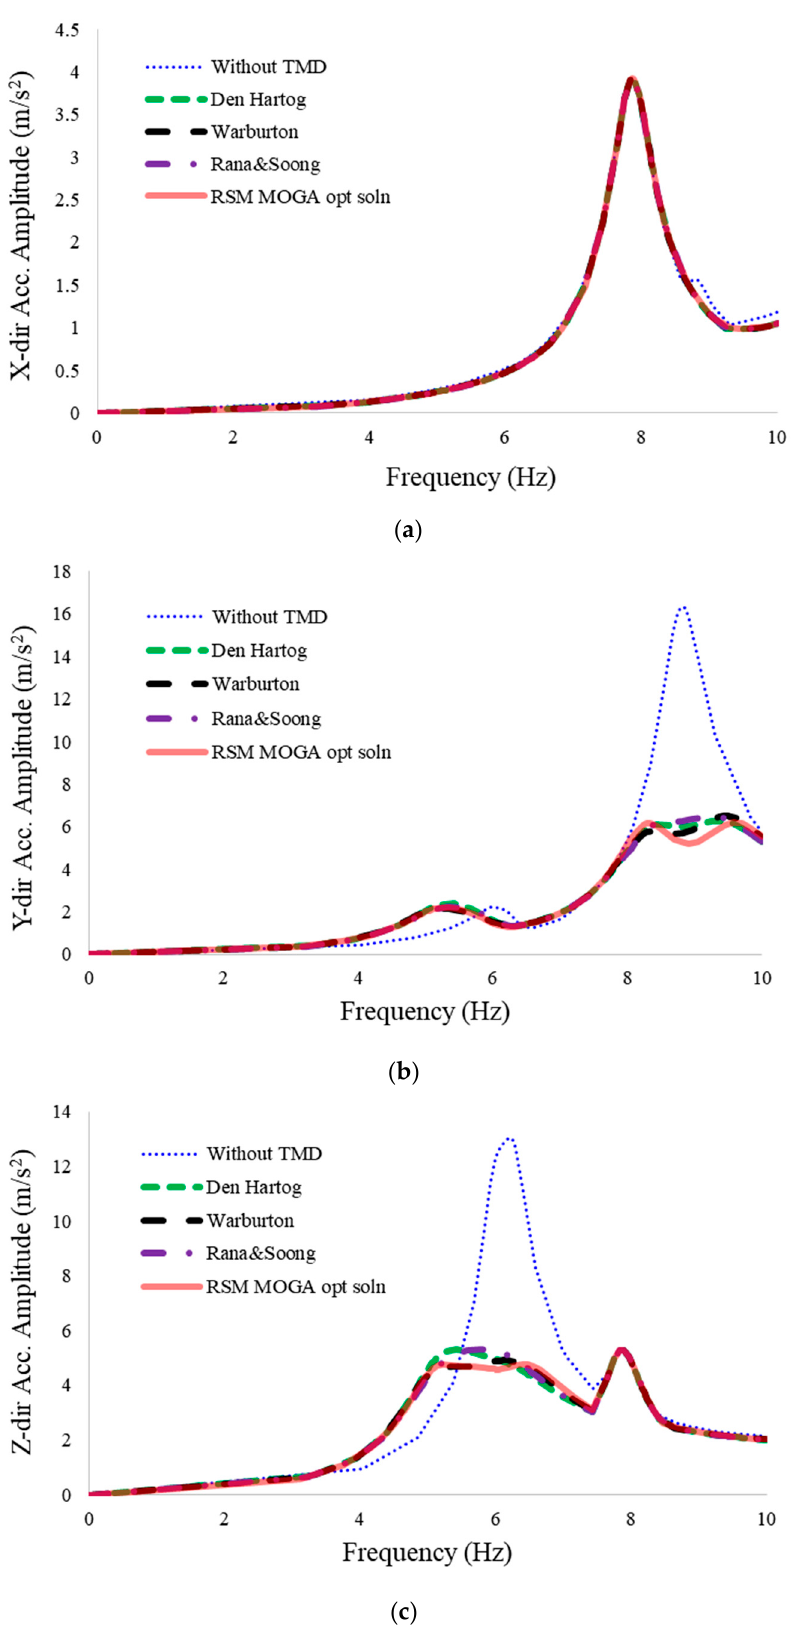
Figure 8. Comparison of the maximum frequency acceleration responses in the overall piping system: ( a ) X direction; ( b ) Y direction; ( c ) Z direction.